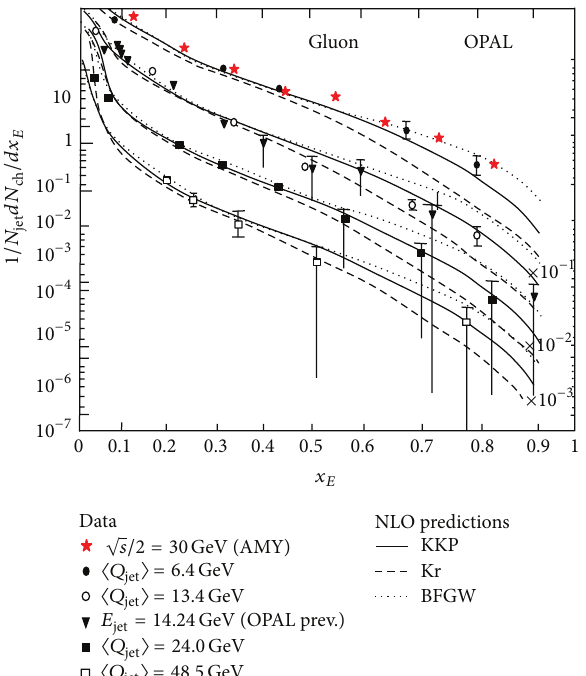
Figure 13: Dependency of the fragmentation functions of gluon jets to 𝑥 𝐸 in different scales at different c.m. energies